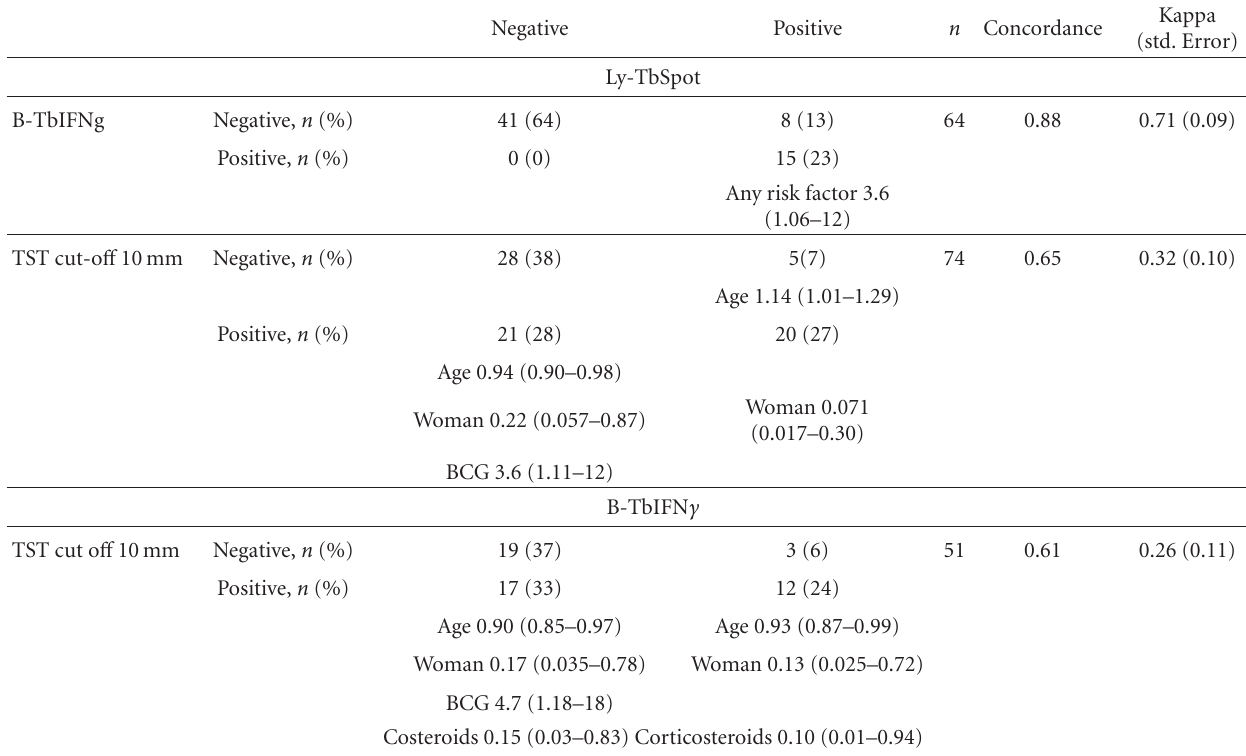
Table 6: The agreement between IGRAs and TST with negative/negative as the reference